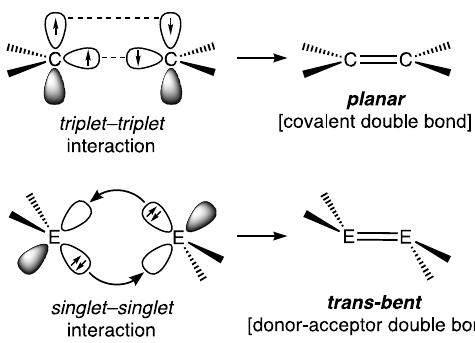
Figure 1. Formation of the planar alkene C=C by the triplet–triplet interaction of two carbenes >C: vs. formation of the trans -bent heavy alkene analogue E=E by the singlet–singlet interaction of two heavy carbene analogues >E:.